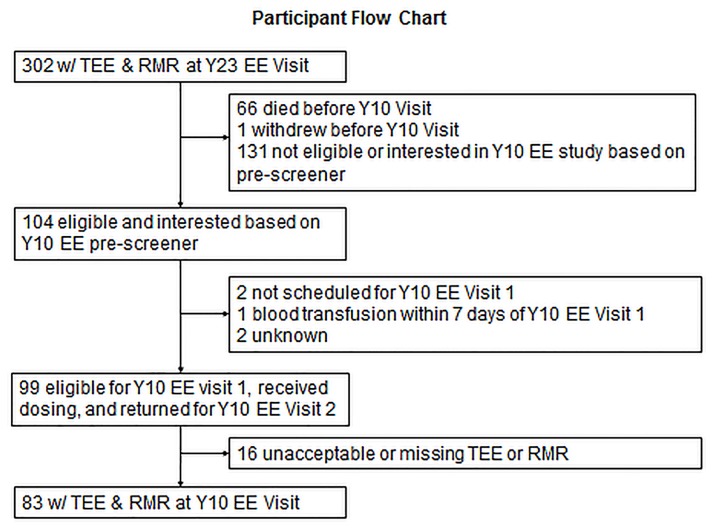
Consort diagram of participant flow for follow-up (FU) doubly-labeled water (DLW) visit.